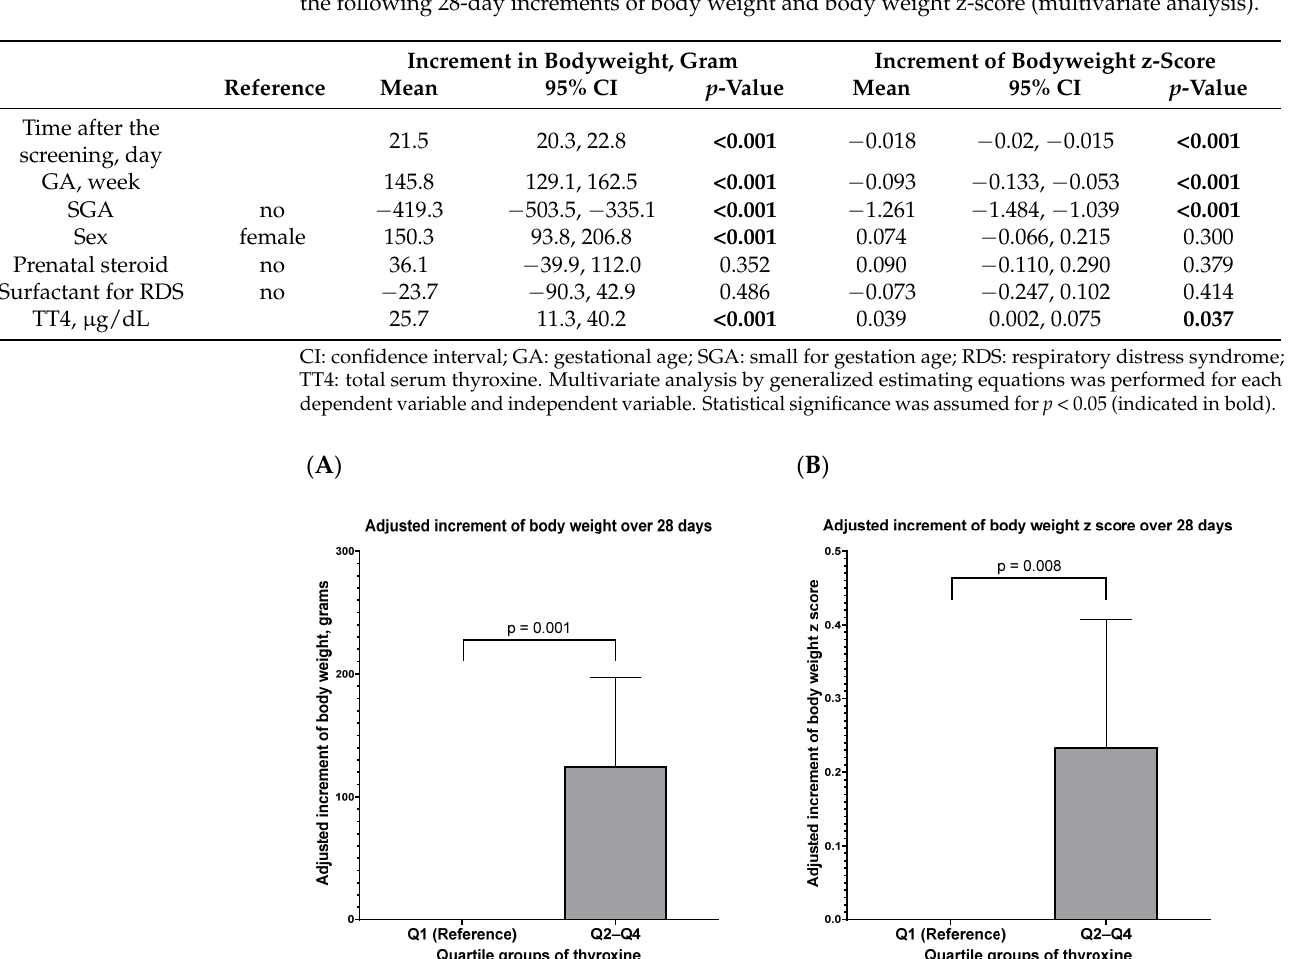
Figure 3. The quartiles of thyroxine concentration and their association with the 28-day increments in body weight ( A ) and body weight z-score ( B ). Adjusted for gestational age, sex, prenatal steroid, small for gestational age, and respiratory distress syndrome requiring surfactant use. Thyroxine group: Q1: ≤ 5.28; Q2: 5.29–6.40; Q3: 6.41–7.85; Q4: > 7.85 µ g/dL (detailed statistics in Supplementary Table S3).